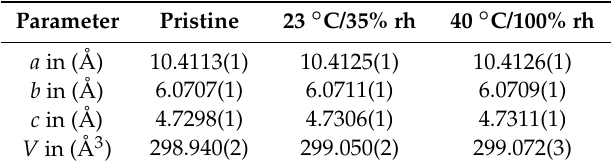
Table 2. Structural data determined using the RIETVELD refinement for pristine and aged powder samples obtained by neutron diffraction (SPODI at MLZ); The standard 1 σ -deviations of the refinement for the last digits are given in parentheses.